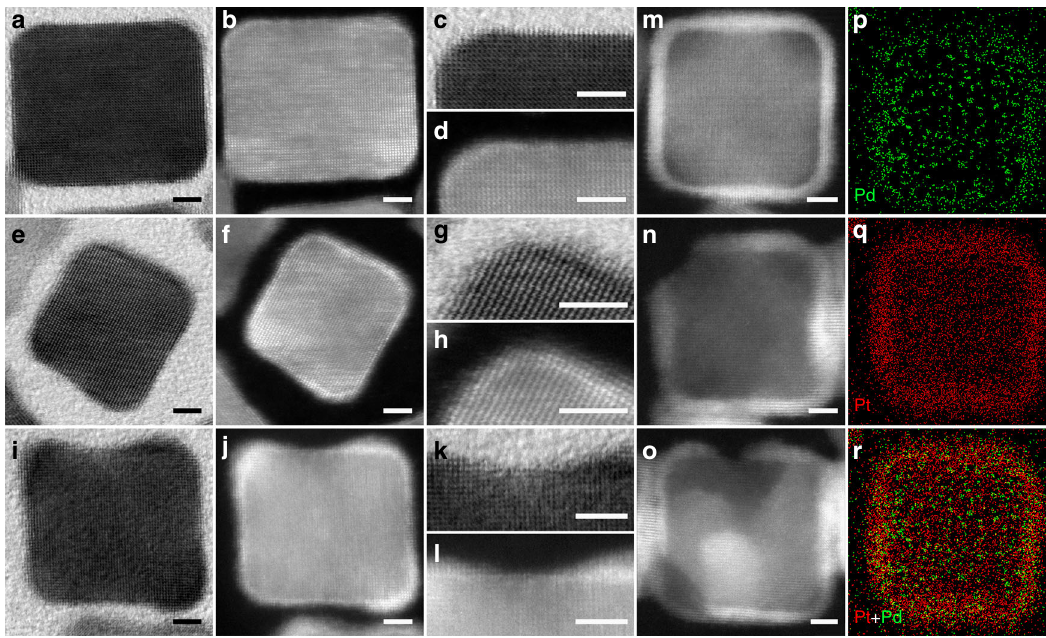
Fig. 3 HRTEM and HAADF-STEM characterizations of cubes. a – l HRTEM and HAADF-STEM micrographs of regular ( a – d ), corner ( e – h ) and terrace ( i – l ) defected Pd@Pt cubes before etching. m – o Pt cages derived from cubes of regular, with corner and terrace defects, respectively. p – r EDS elemental mapping of Pt cage in m . Scale bars in all panels are 2